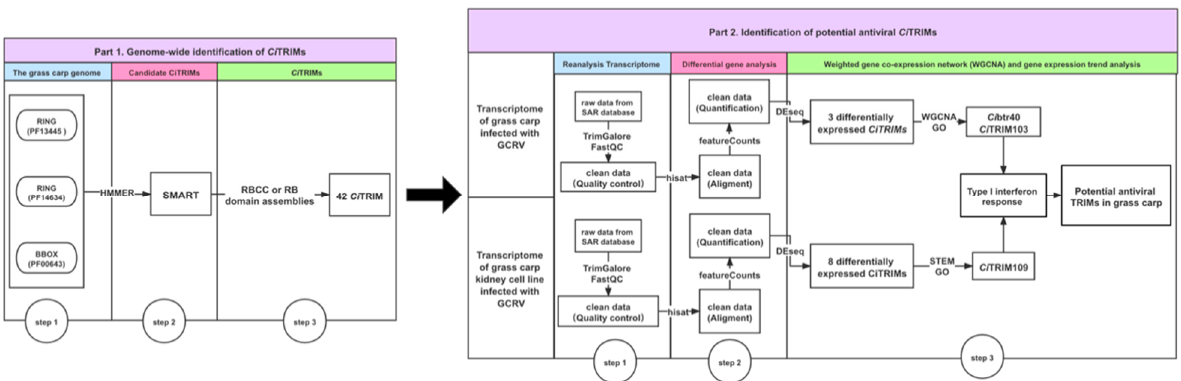
Figure 8. The overall framework for genome-wide identification of potential antiviral TRIMs in grass carp using transcrip- tomes in this study. First, the candidate Ci TRIMs containing RBCC, or RB domain assemblies were searched from the grass carp genome using the HMMER software, followed by removing redundancy through SMART analysis; finally, 42 Ci TRIMs were identified. Secondly, two published transcriptomic datasets based on experiments with grass carp individuals and cells infected with GCRV were downloaded from the SRA database (SRP095827, PRJNA597582 and PRJNA597542), followed by reanalysis. Eleven differentially expressed Ci TRIMs were identified through fold changes > 2 and FDRs (or adjusted p -values) < 0.05 using the DESeq R package. Through WGCNA and gene expression trend analysis, 3 TRIMs-B30.2, including Ci TRIM103, Ci btr40 and Ci TRIM109, associated with the type I interferon response during GCRV infection, were deduced as potential antiviral TRIMs in grass carp.